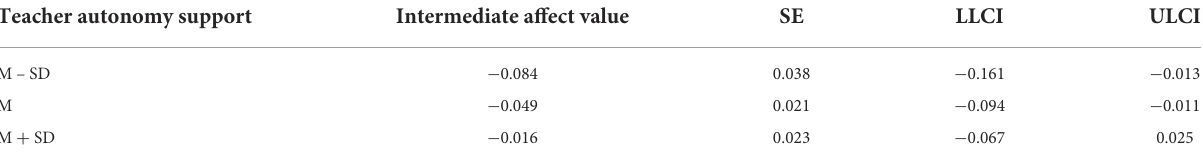
TABLE 5 Moderating effect of different levels of teacher autonomy support on the relationship between weight self-stigma and engagement among obese